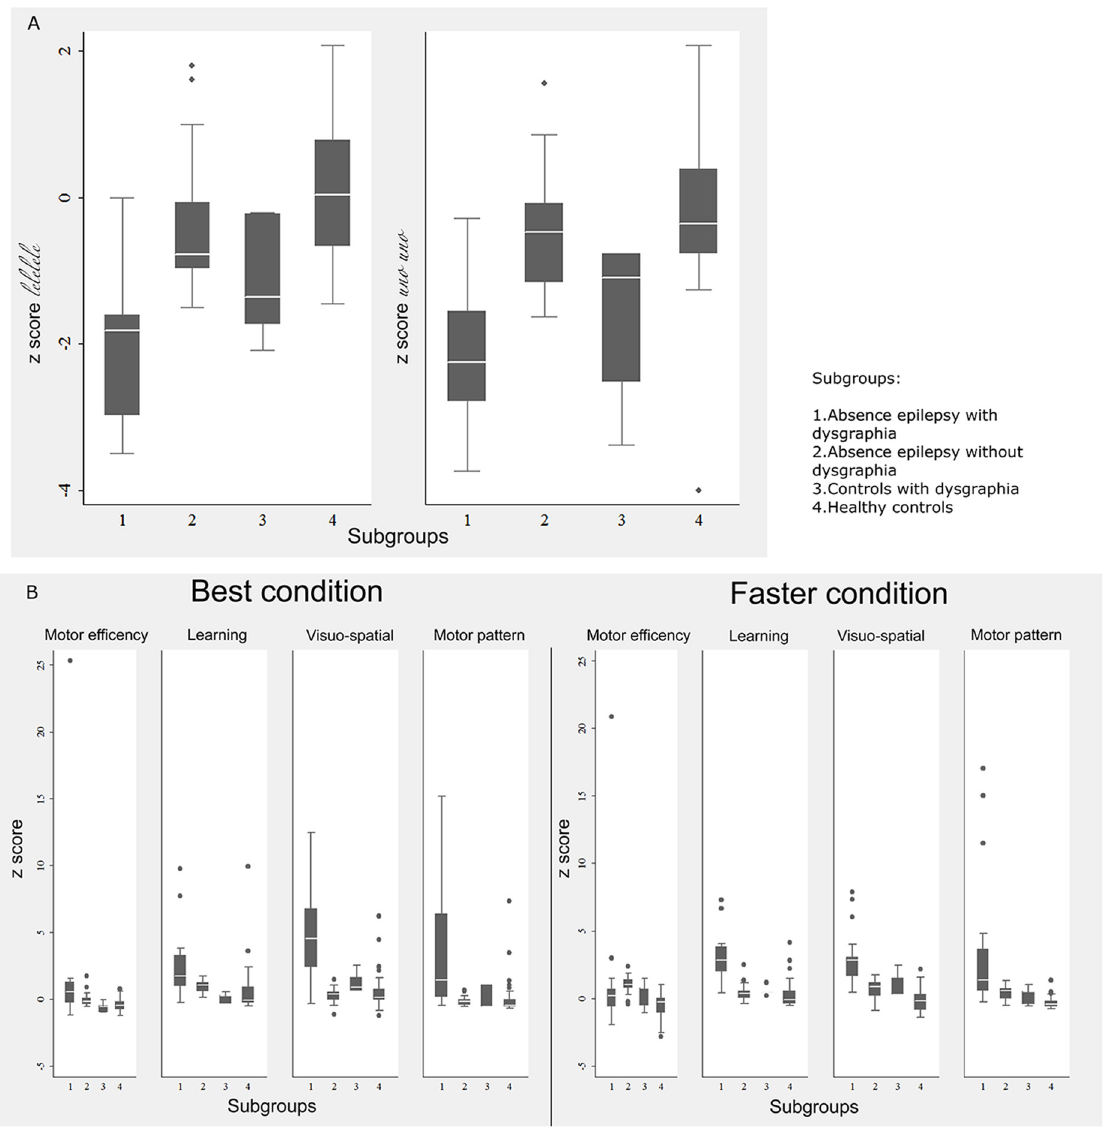
Fig 3. Handwriting fluency and DGM-P test box plot. Box plot of ( A ) handwriting fluency test and ( B ) DGM-P test with z-scores in the four subgroups.